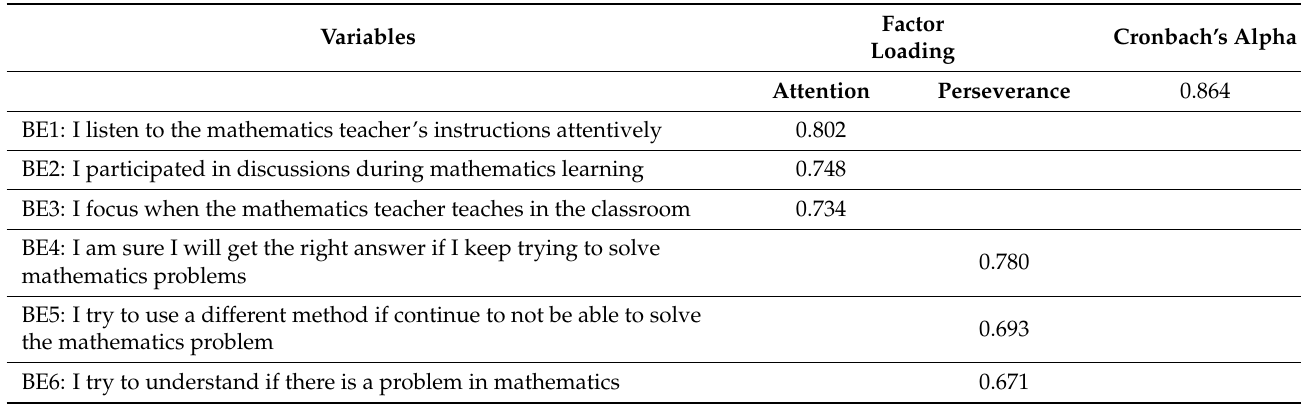
Table 3. Reliability values and factor loading for behavioural engagement.